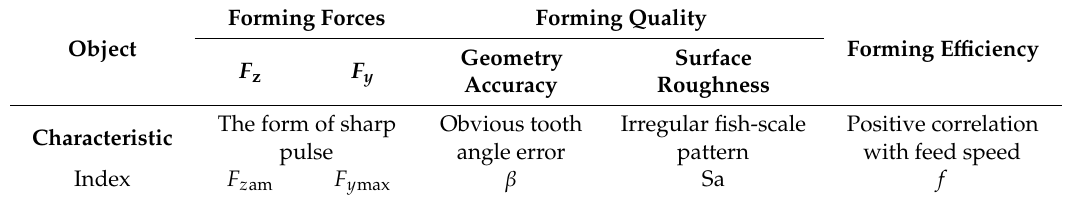
Table 2. Research objectives and their corresponding indices.